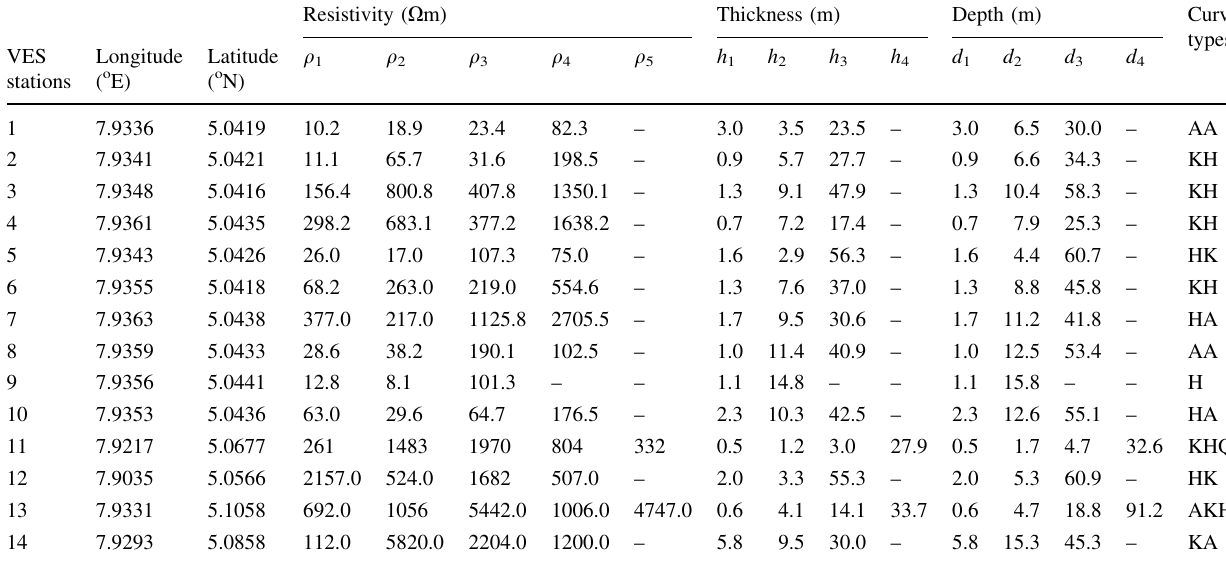
Table 1 Summary of results of resistivity survey from computer modeling Resistivity ( X m)